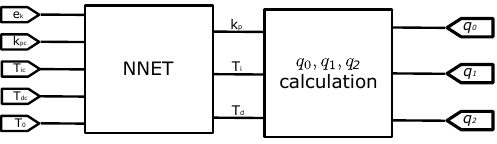
Figure 15. The calculation for q 0 , q 1 , and q 2 .